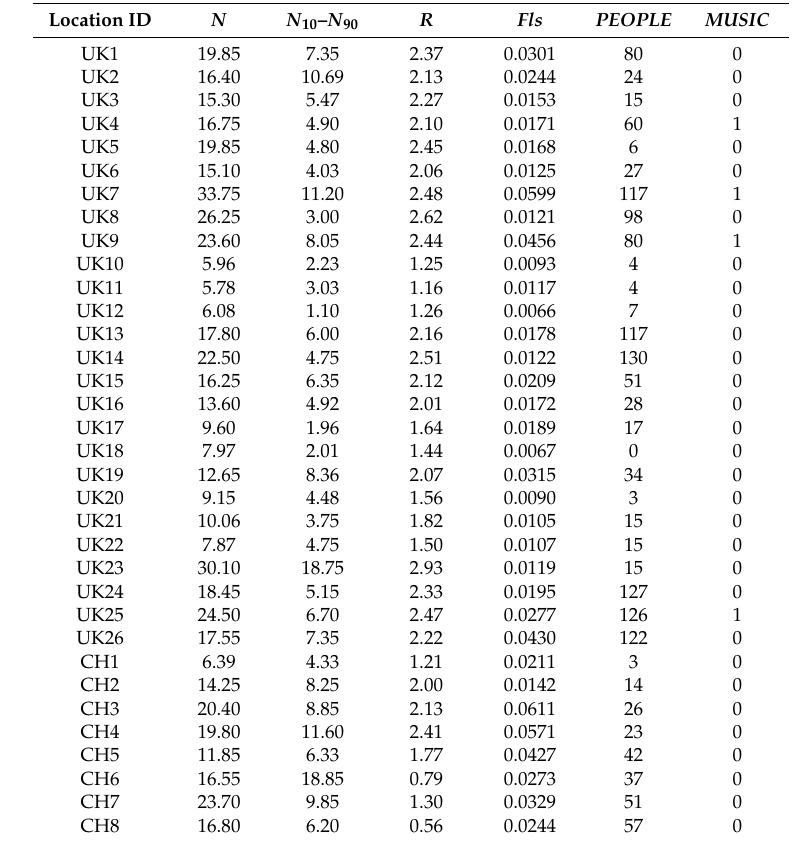
Table 2. Computed indicators for the selected locations of the